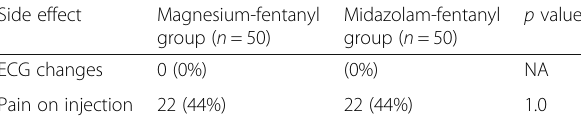
Table 6 Incidence of undesired side effects in both study